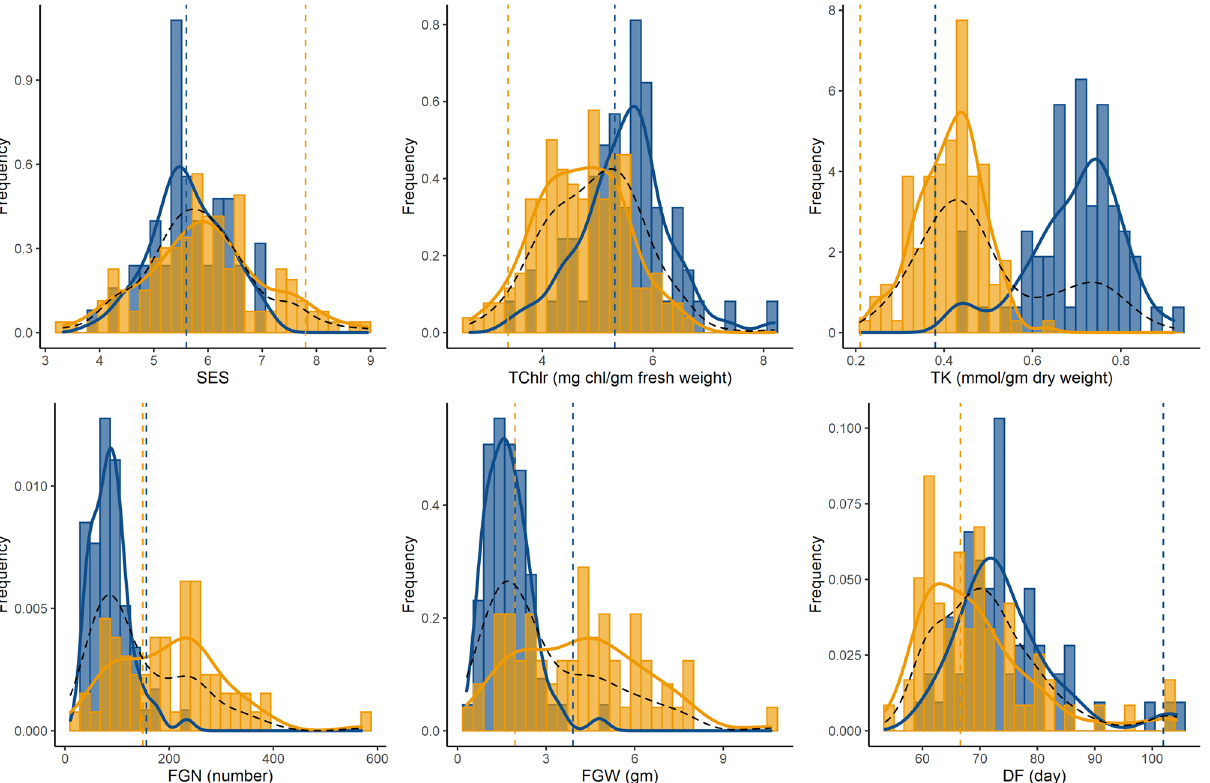
Figure 1. Frequency distribution of traits showing transgressive segregation in the F 2 population and the individual subsets of cross directions. Blue and orange histograms indicate samples from Horkuch ♀ and IR29 ♀ cytoplasm respectively. Curves in blue and orange indicate distribution plots of Horkuch ♀ and IR29 ♀ cytoplasm respectively and dotted curve in black indicates the distribution plot of total population. Parental values are marked by a dotted vertical line where blue indicates Horkuch and orange indicates IR29 .